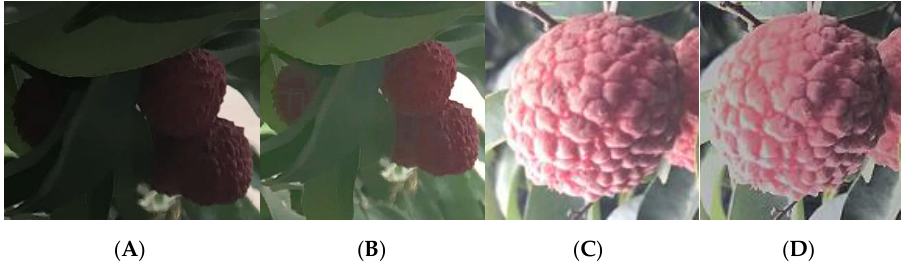
Figure 4. Effect of lychee image illumination compensation. ( A ) Weakly illuminated lychees. ( B ) Weakly illuminated lychees after illumination compensation. ( C ) Overexposed lychees. ( D ) Overexposed lychees after illumination compensation.